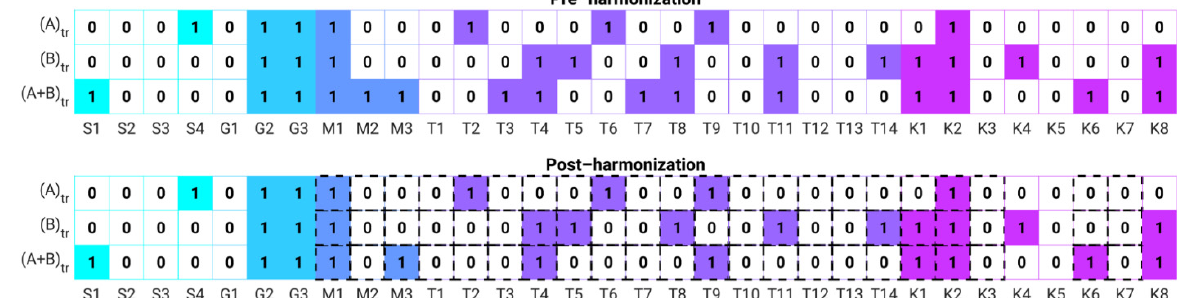
Figure 6. Feature selection by feature sets used in the study. Top: pre-harmonization features; bottom: post-harmonization features. Abbreviations in the figure correspond to the features listed in Table 2. Squares outlined with a dashed line indicate those for which harmonization was conducted.